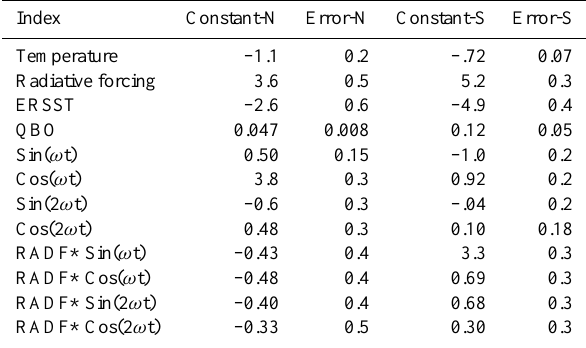
Table 1. Constants of the regressions analysis for the Northern and Southern Hemisphere. The errors are 2 σ